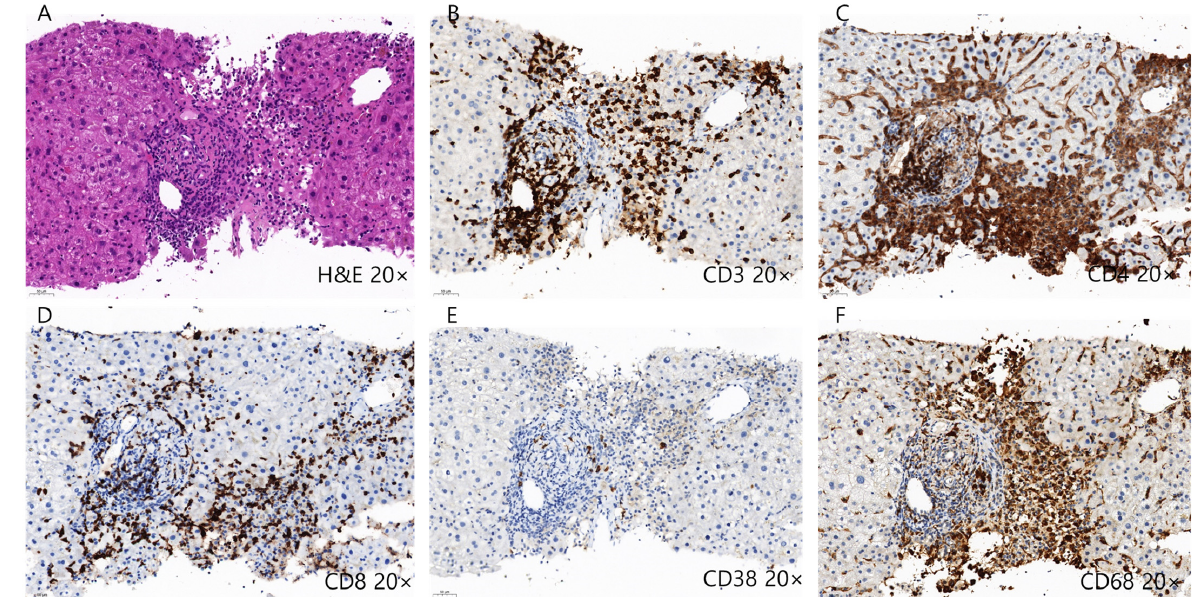
Figure 3. Histopathology of drug-induced liver injury induced by immune checkpoint inhibitors.